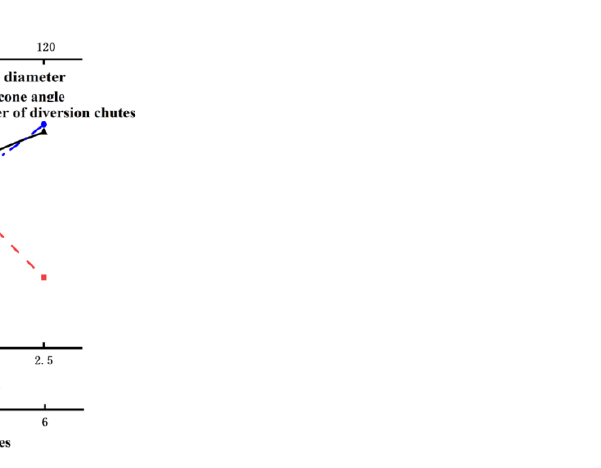
Figure 4. The influence of key structures on the average application rate of sprinkler irrigation.